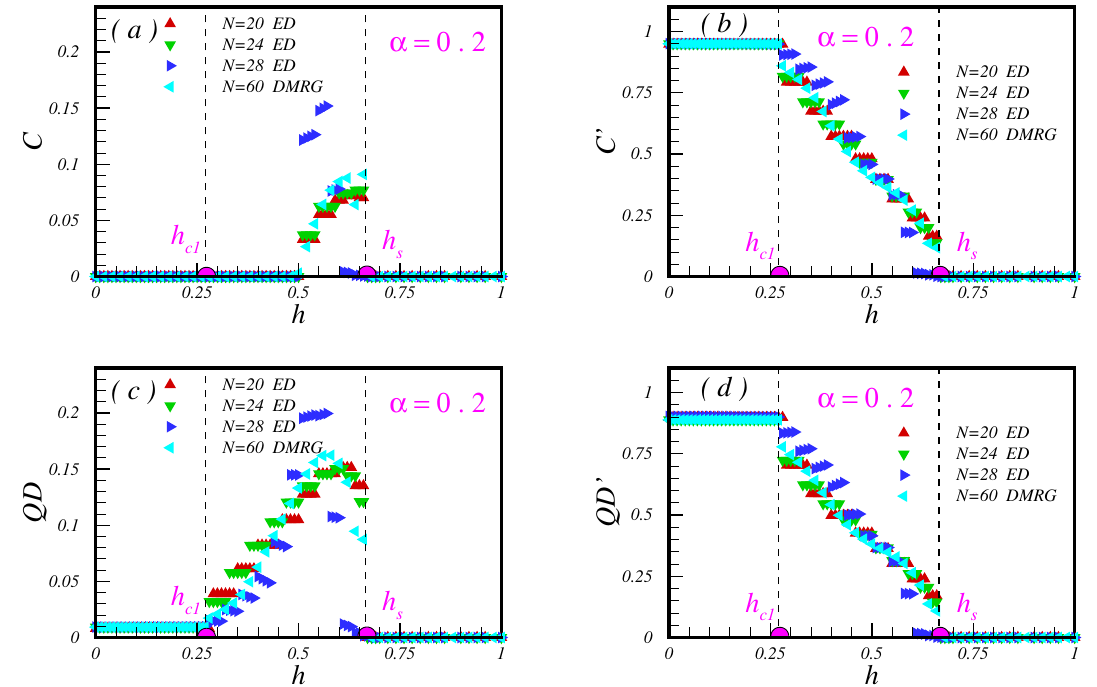
Figure 5. The concurrence and the QD between pair of spins on bonds with exchange coupling J ( a , c ) and J ′ ( b , d ) versus the TF. Lanczos results are presented for α = 0.2 and clusters with N = 20, 24, 28 spins and also DMRG results for N = 60